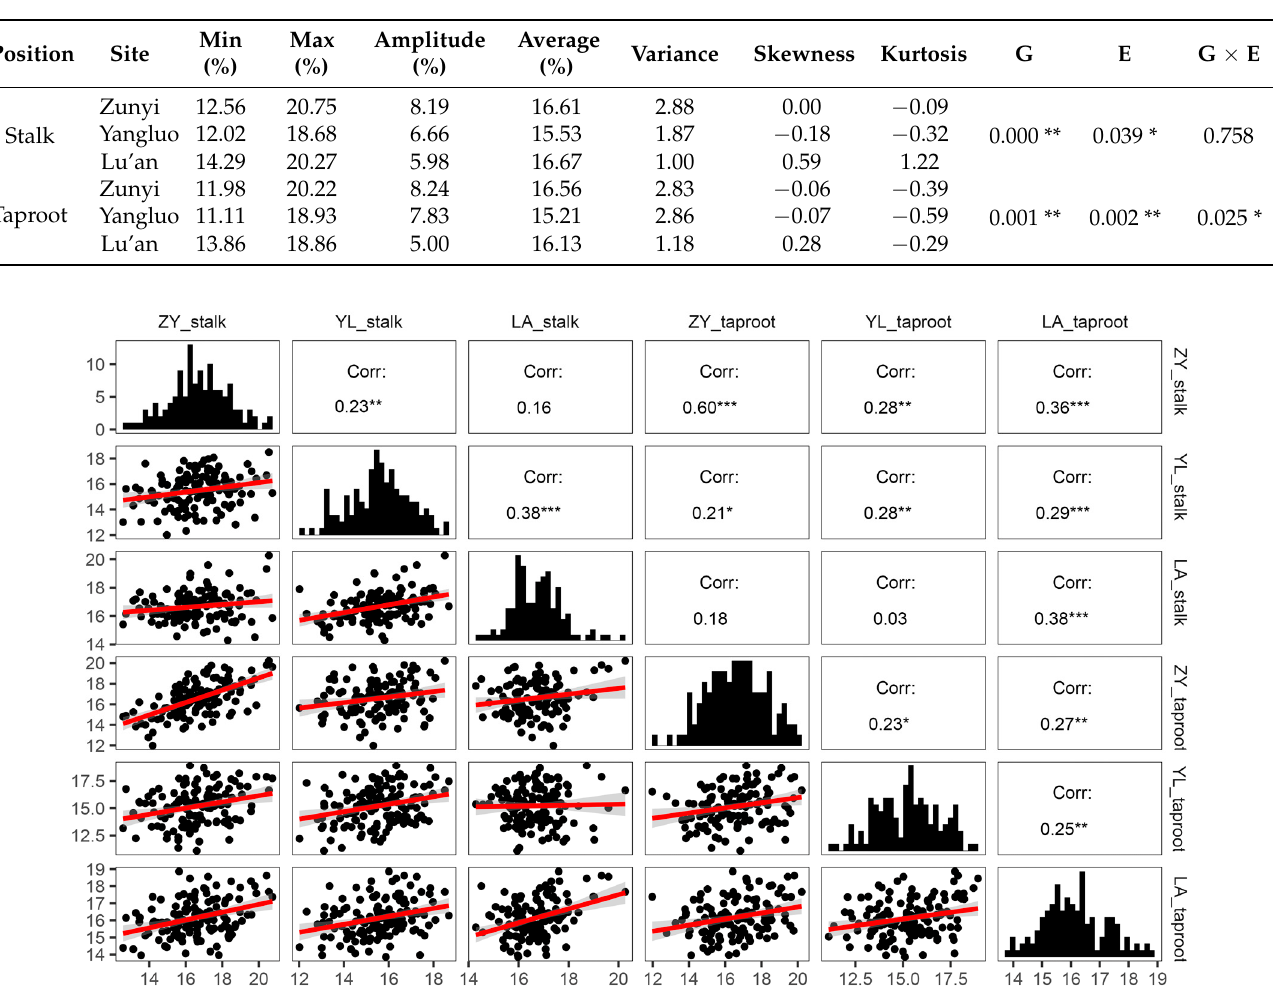
Figure 1. Association analysis of hemicellulose content in different tissues of 139 accessions in different environments. The diagonal line is the bar graphs of the hemicellulose content, the lower left corner is the dotted graph of the hemicellulose content and the upper right corner is the association coefficient between the hemicellulose content in each region and part. Corr means correlation coefficient. *, ** and *** indicate significant correlation at the levels of 0.05, 0.01 and 0.001, respectively.